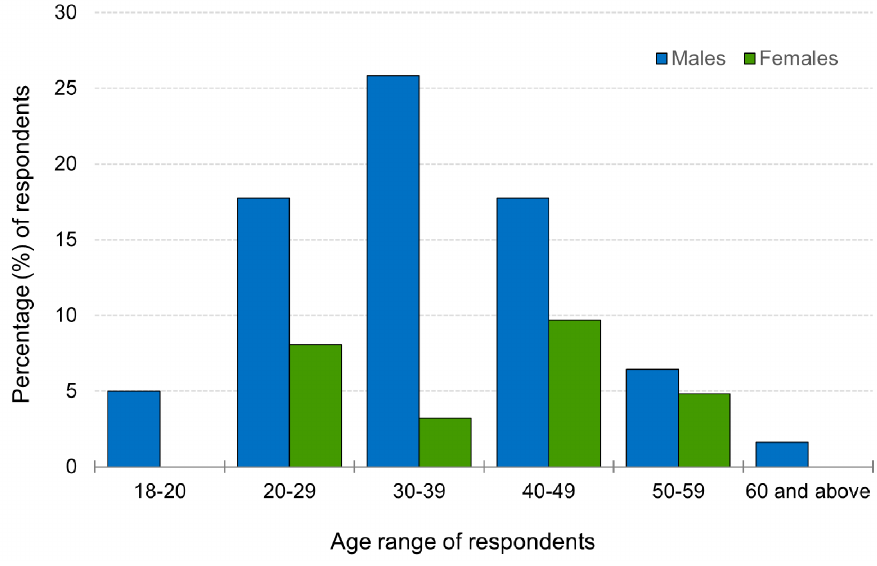
Figure 2. Age and gender distribution of survey respondents in both study